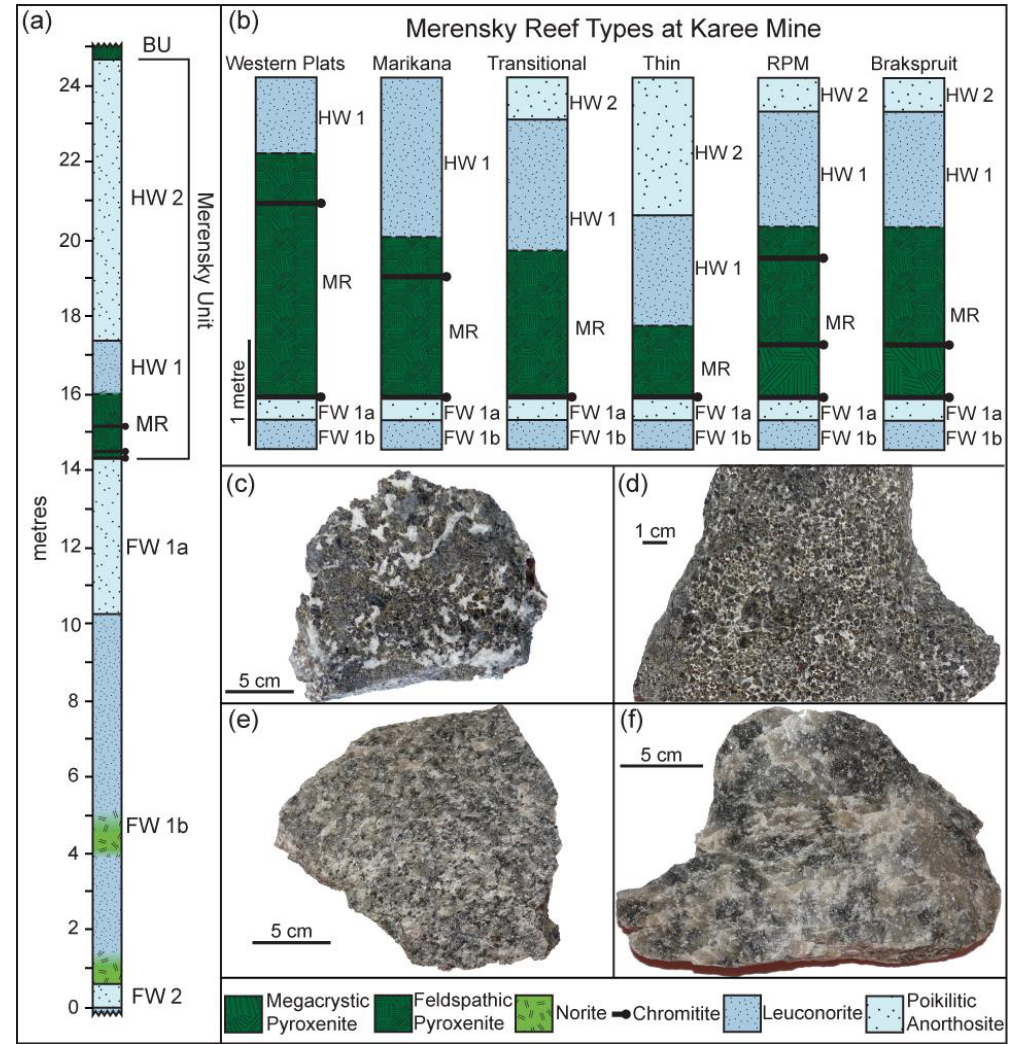
Figure 2. ( a ) Drill core log through the Merensky sequence from the FW 2 poikilitic anorthosite to the Bastard Unit (BU) pyroxenite, core courtesy of Lonmin Platinum; ( b ) Type variations of the Merensky Reef at Karee Mine, data courtesy of Lonmin Platinum; ( c ) Megacrystic feldspathic orthopyroxenite; ( d ) Feldspathic orthopyroxenite; ( e ) HW 1 leuconorite; ( f ) HW 2 poikilitic anorthosite. Abbreviations: MR = Merensky Reef, FW = footwall, HW = hanging wall.